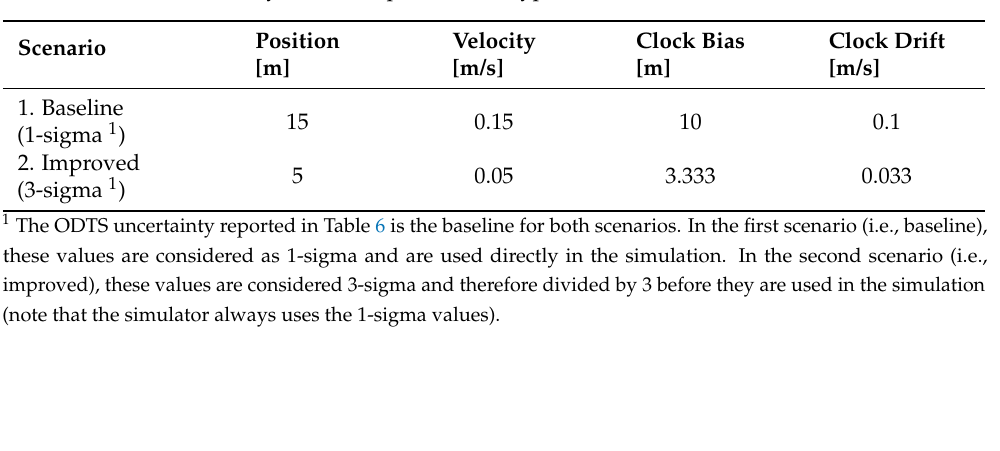
Table 10. ODTS uncertainty definition per scenario